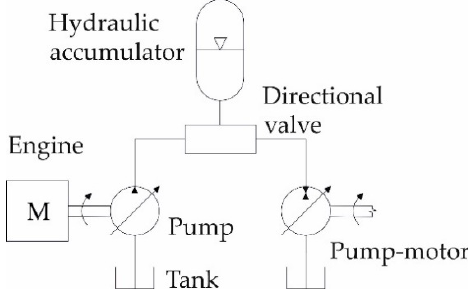
Figure 5. Series configuration.